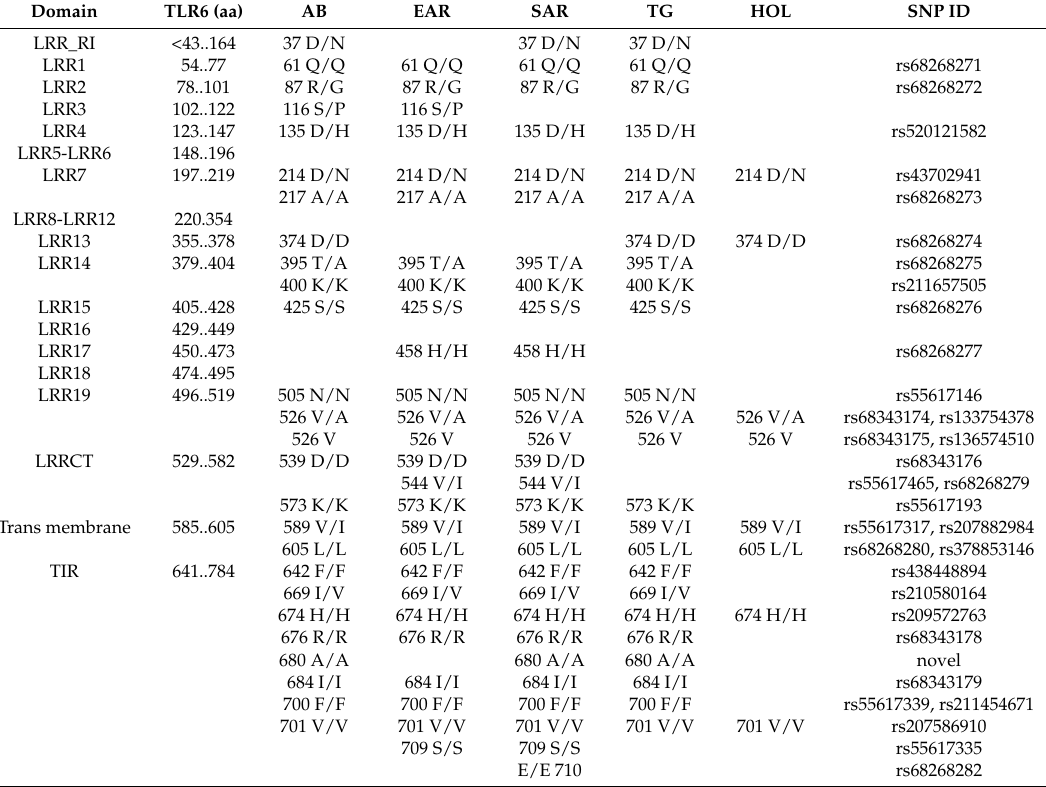
Table 5. Missense and synonymous variations on protein domain level of TLR6 (according to reference sequence